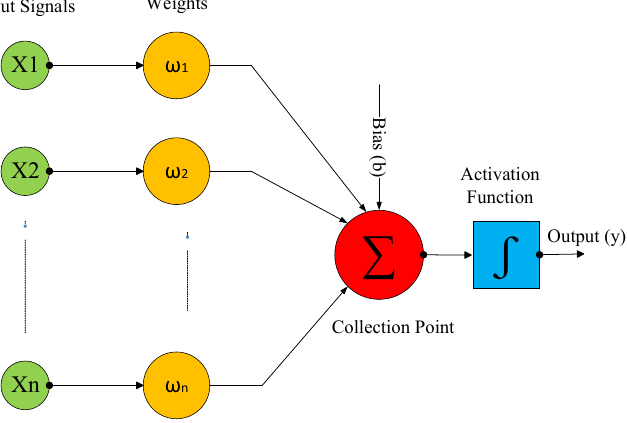
Figure 7. Block diagram model of a neuron.